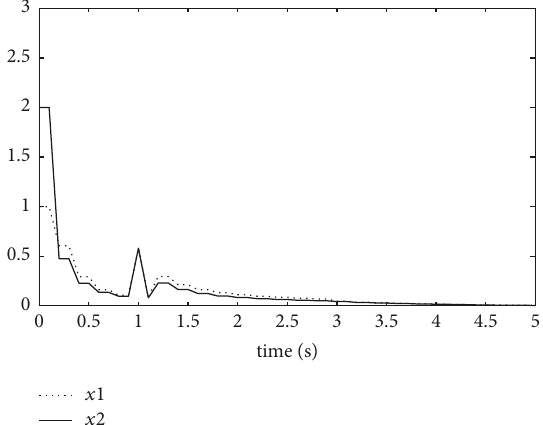
Figure 1: State trajectories of closed-loop system (1).